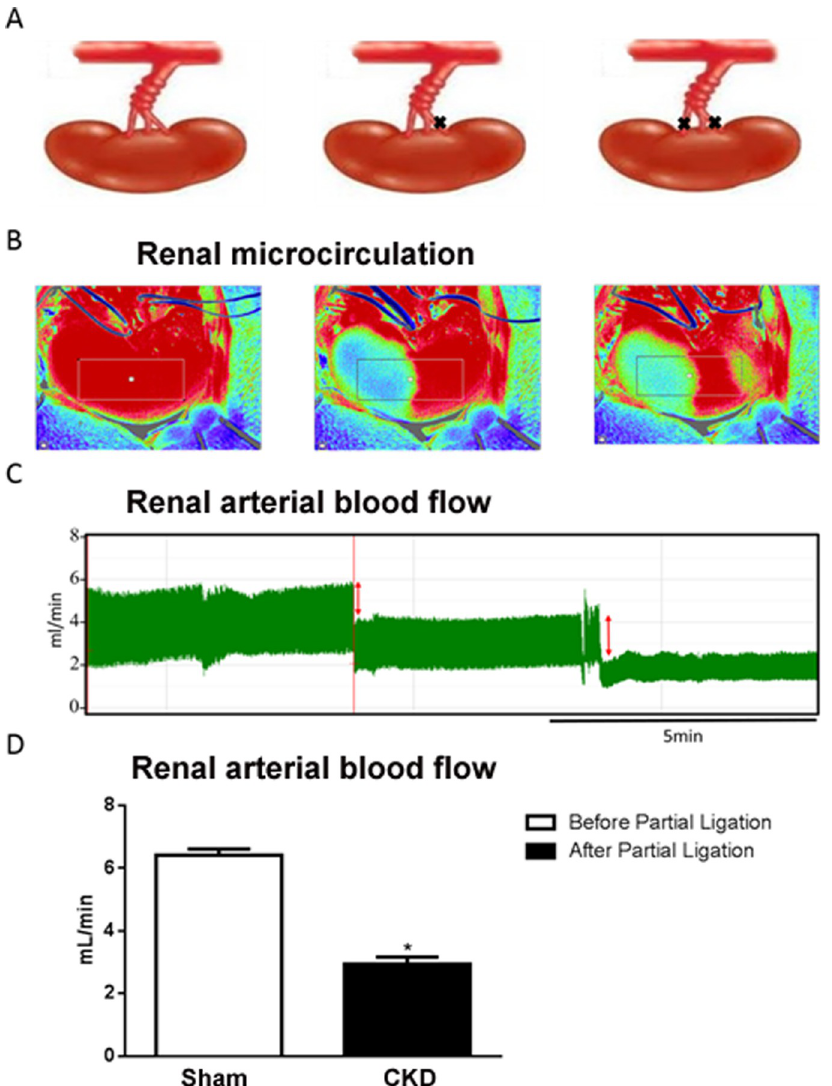
Fig 2. Evaluation of the CKD (5/6 nephrectomized) model (A) on left renal microcirculation (B), left renal arterial blood flow (C) for developing CKD. Partial ligation of left renal artery led to a near 2/3 reduction of left renal microcirculation (B) and renal arterial blood flow (C, D) in CKD group vs. Sham group. Data are expressed as mean ± SEM (n = 6). � P < 0.05 vs. Sham group.